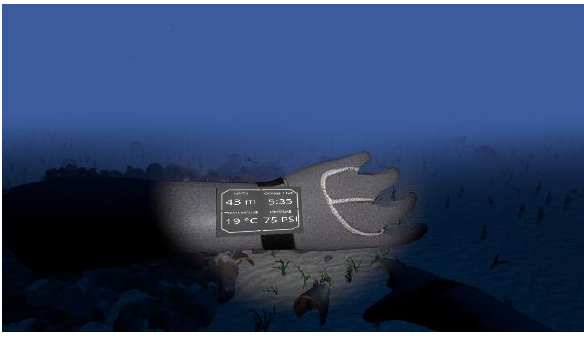
Figure 9. Interface options for the